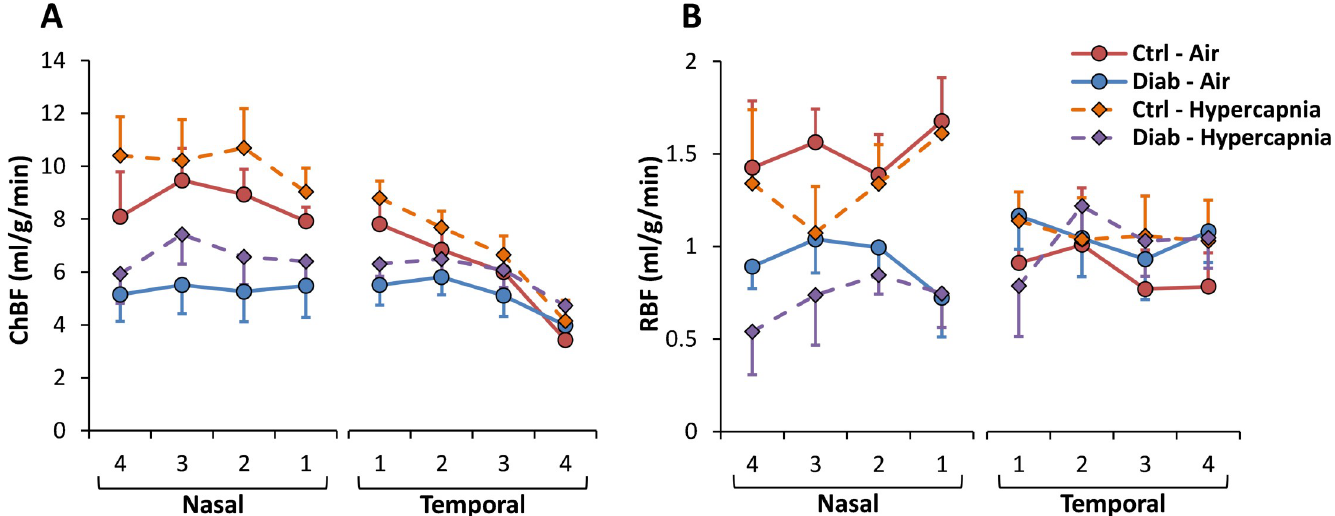
Fig 5. Choroidal blood flow (ChBF) (A) and retinal blood flow (RBF) (B) plotted along the length of the retina for Ctrl and Diab mice under air and hypercapnia. Blood flow data from each retinal region (nasal or temporal), which were taken pixel-by-pixel, were averaged over four bins in each region for this plot. Error bars show standard